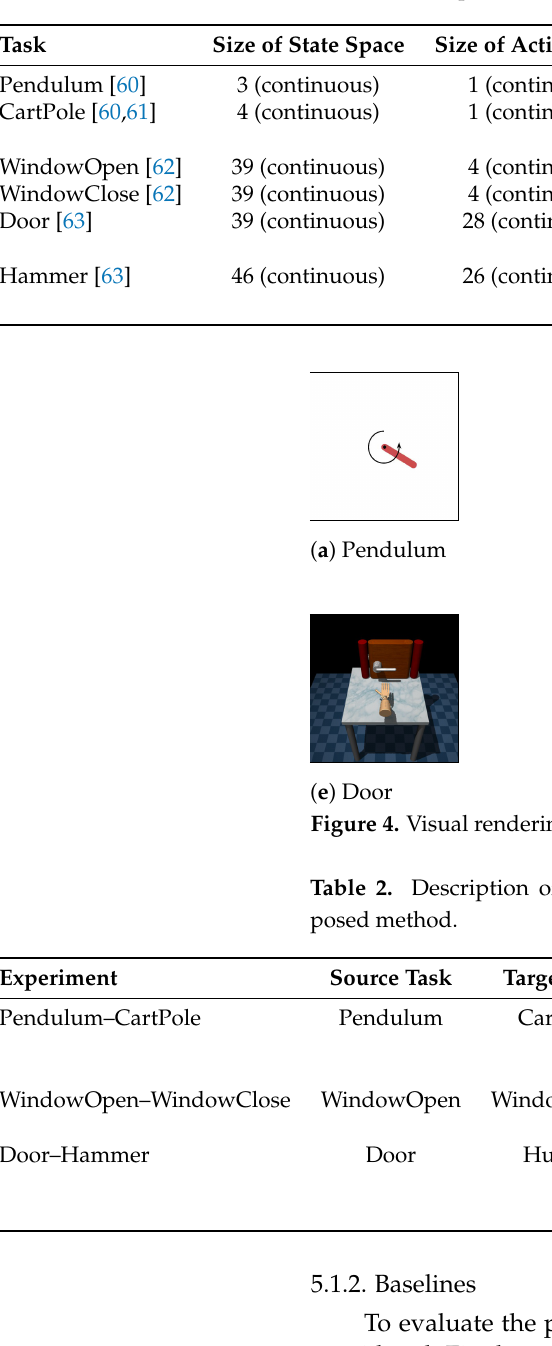
Table 1. Description of six simulated tasks used in the experiment.